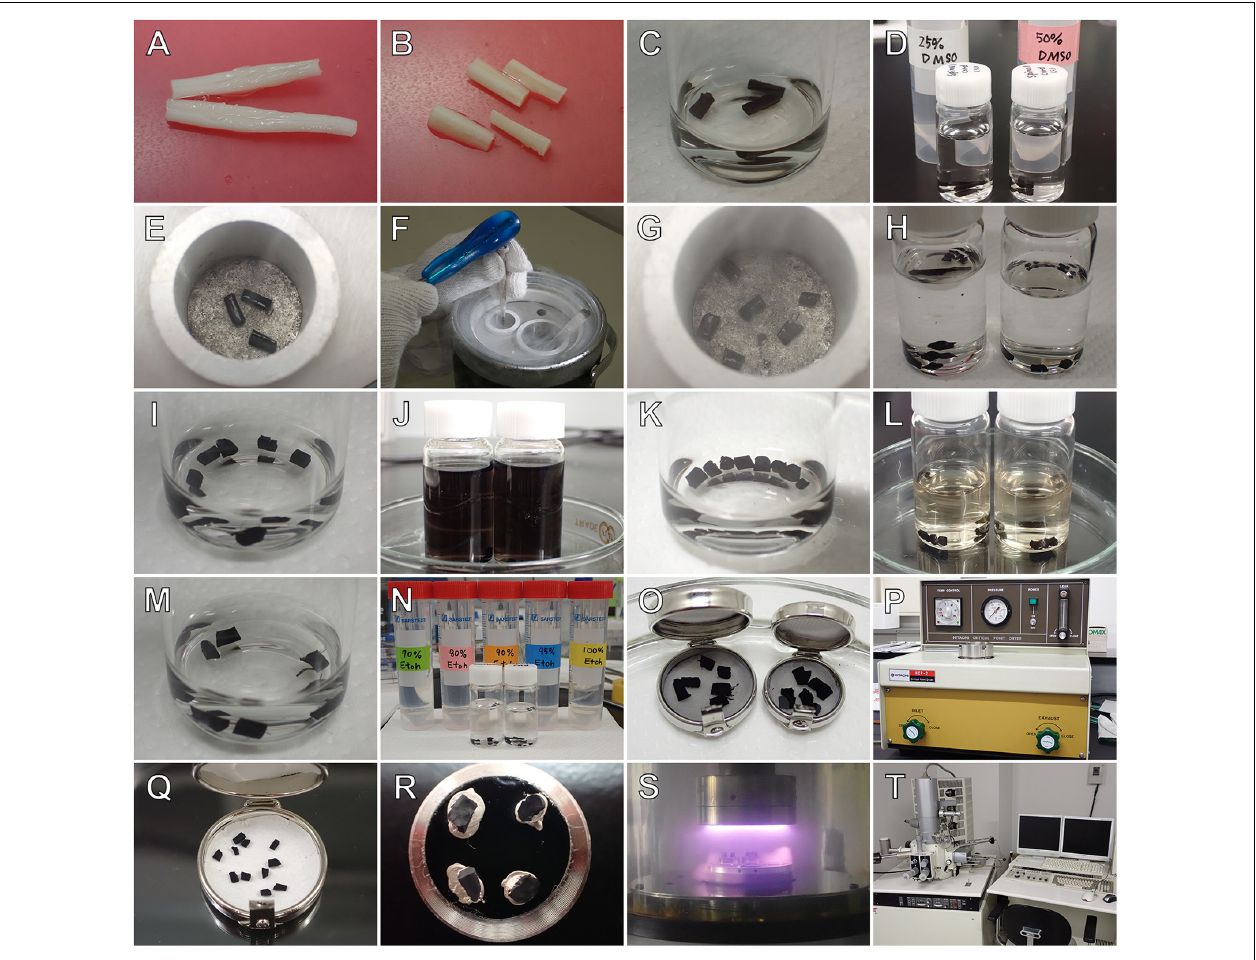
FIGURE 1 | Outline of the osmium maceration method. After perfusion fixation, tissues are removed (A) , cut into small pieces (B) , and further fixed with osmium tetroxide (OsO 4 ) (C) . They are then immersed in 50% dimethyl sulfoxide (DMSO) solution (D) , frozen on an aluminum plate precooled with liquid nitrogen (E) , and freeze-cracked into two pieces using a screwdriver and hammer (F) . The freeze-cracked pieces (G) are placed back into the DMSO solution for thawing (H) and refixed with OsO 4 (I) . For cell maceration, specimens are immersed in 0.1% OsO 4 for several days (J) . The macerated tissues are further fixed with OsO 4 (K) , treated with 1% tannic acid (L) , placed in 1% OsO 4 (M) , dehydrated in a series of graded ethanol (N) , transferred to isoamyl acetate (O) , and dried in a critical point dryer (HCP-2; Hitachi) (P) . Dried specimens (Q) are mounted onto SEM holders with silver paste (R) , coated with platinum-palladium in an ion-sputter coater (E1030; Hitachi) (S) , and observed in a field emission scanning electron microscope (S-4100; Hitachi) (T)